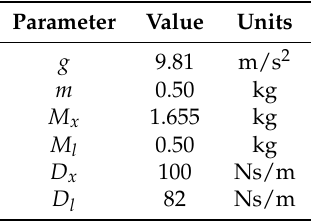
Table 2. Parameters of the 3 degrees of freedom (DOF)